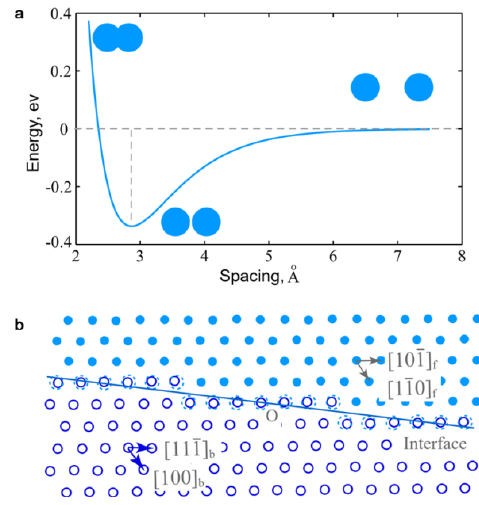
Figure 1. Schematic diagram to show the physical basis for atomic matching in the interface. ( a ) The total energy varies with the spacing between the same atoms, ( b ) nearly coinciding atoms in the coherent interface between two 2D lattices.